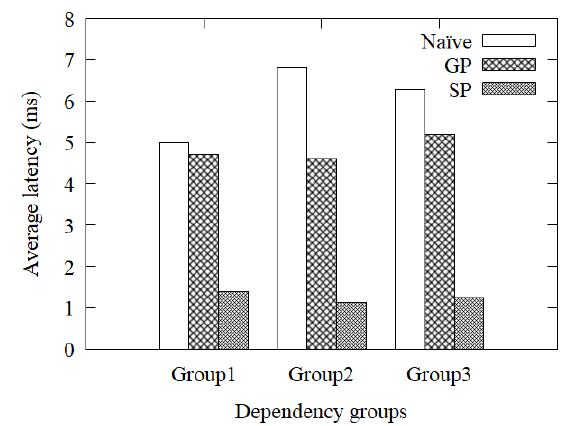
Figure 13. Average latency between the VMs of each